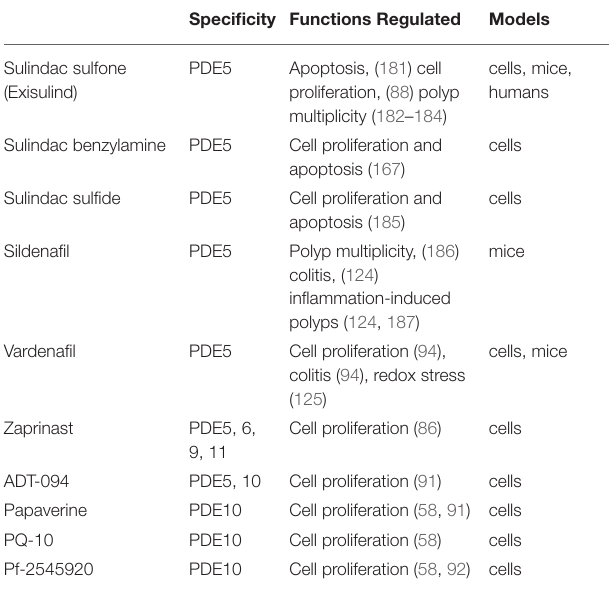
TABLE 1 | PDE inhibitors shown to oppose tumorigenic cell